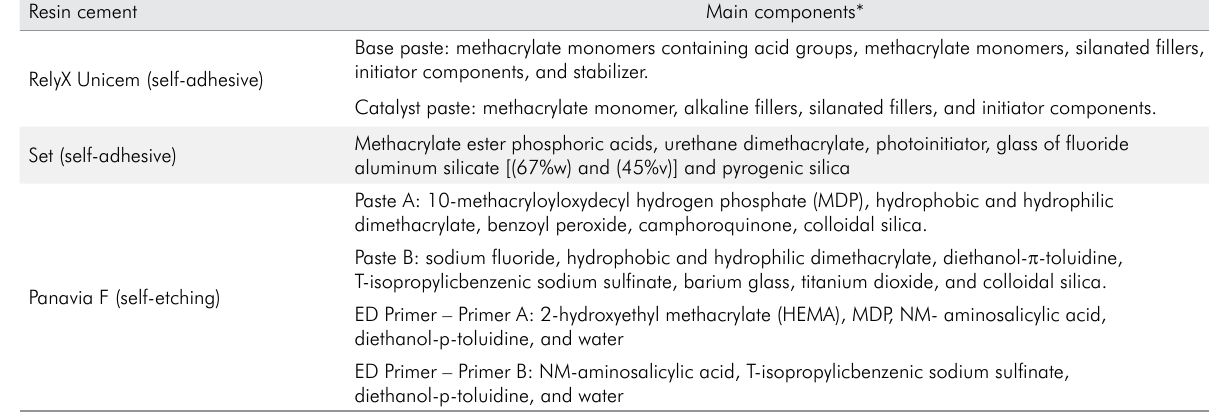
Table 1. Composition of the resin cements used in this study. Resin cement